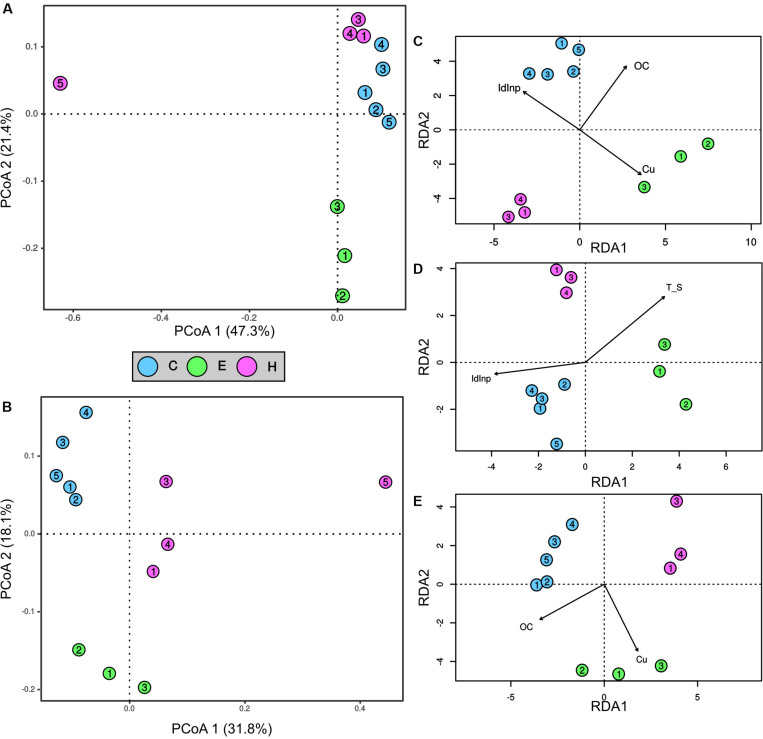
Ordination and contribution of abiotic variables to spatial variation of prokaryotic community structures in surface sediments collected at the port of Cagliari (blue), El Kantaoui (green), Heraklion (pink). PCoA ordination of bacterial (A) and archaeal (B) communities. The percentage of the spatial variation in community structure explained by each axis is indicated in parentheses after the axis label. Redundancy analysis (RDA) ordination diagrams of the first two axes for bacterial (C), SRB (D), and archaeal (E) communities. The constrained sets of environmental variables analyzed are indicated as vectors. Only significant constrained variables are reported.